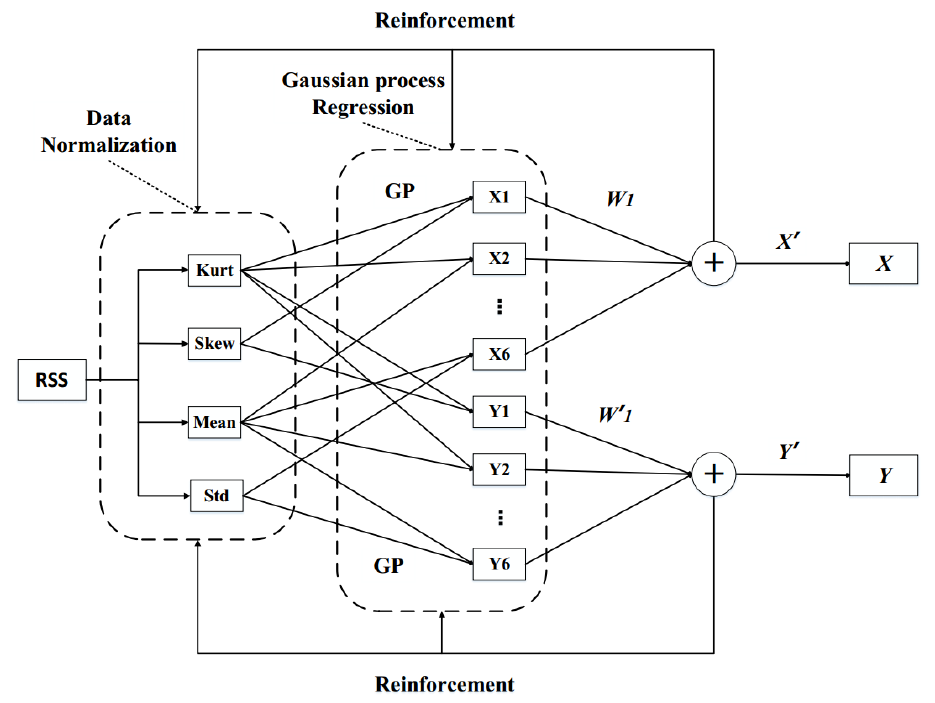
Figure 3. Deep Gaussian Process Regression model.